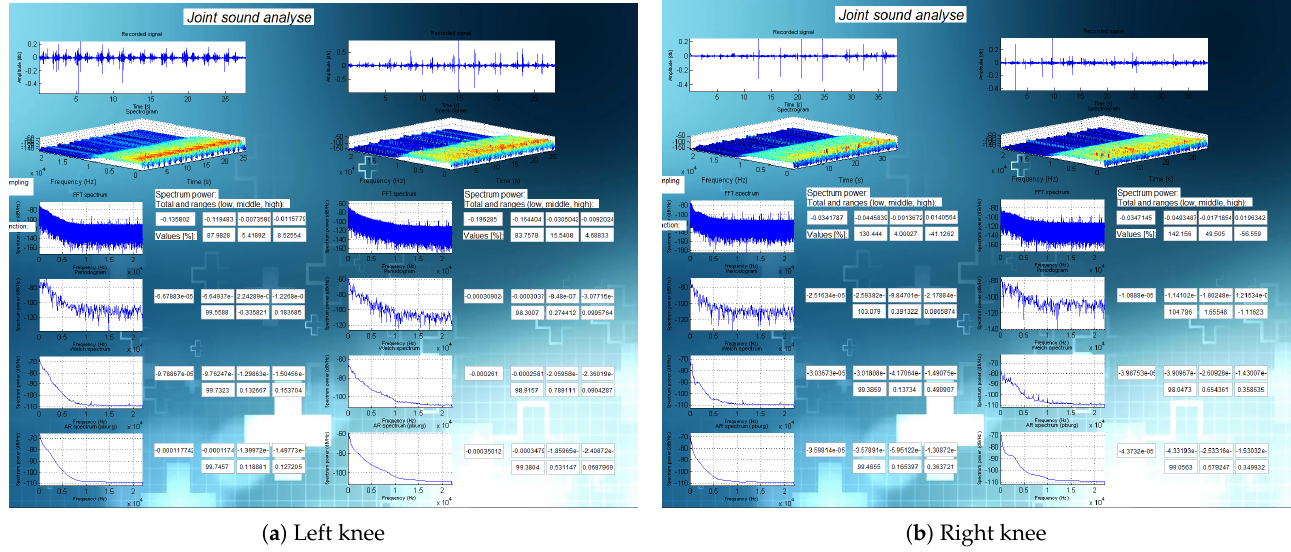
Figure A12. Analysis for subject 12.